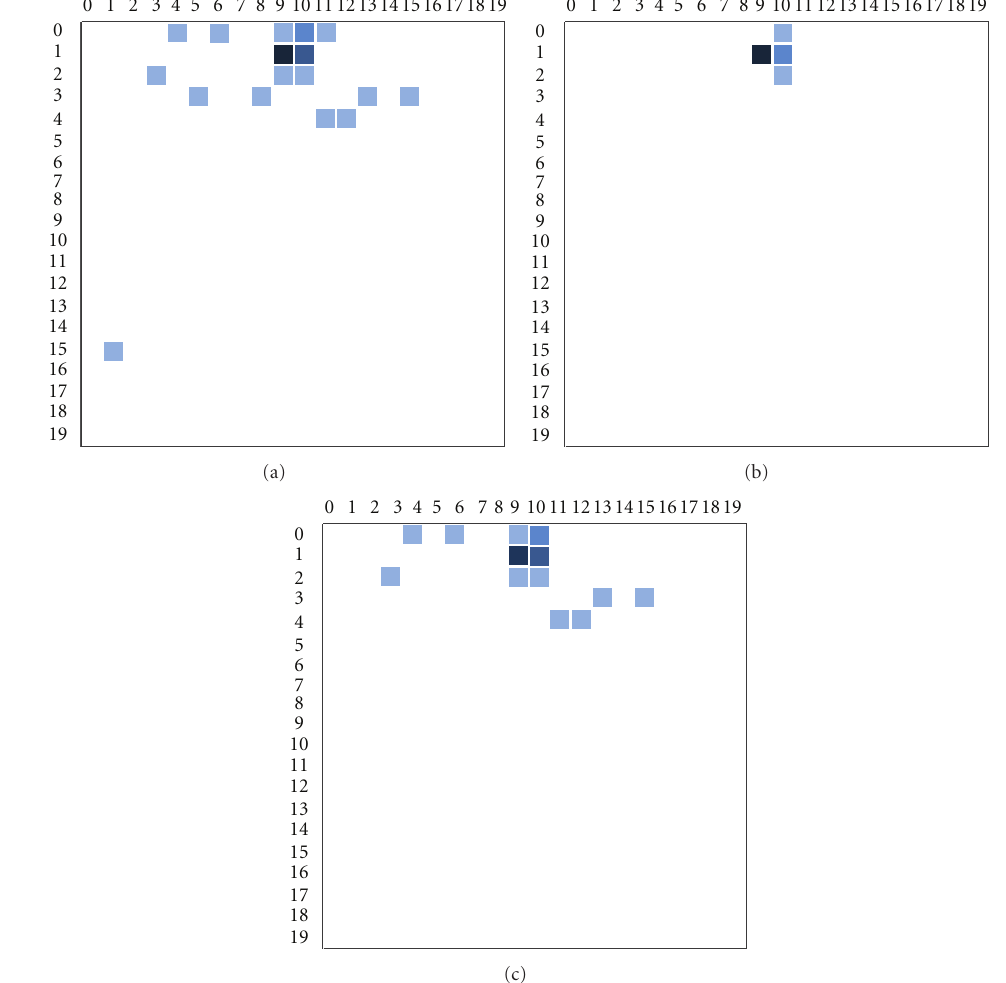
Figure 2: Self-organizing map (SOM) projection of MHC I H2-K b stabilizing peptides. The SOM was trained with 100,603 octapeptides (603 peptides with known H-2K b binding a ffi nity and 100,000 octamer sequences randomly generated according to the amino acid frequency of M. musculus proteins). Only the distribution of the known stabilizing peptides is shown. The color of a neuron reflects its relative occupancy (white: empty; light blue: slightly occupied; dark blue: most occupied). (a) Distribution of the known 251 H-2K b stabilizing octapeptides. (b) Distribution of 80 stabilizing octapeptides with amino acid sequences corresponding to the canonical motif in all three anchor positions. (c) Distribution of 152 stabilizing octapeptides with amino acid sequences corresponding to the canonical motif in two residue